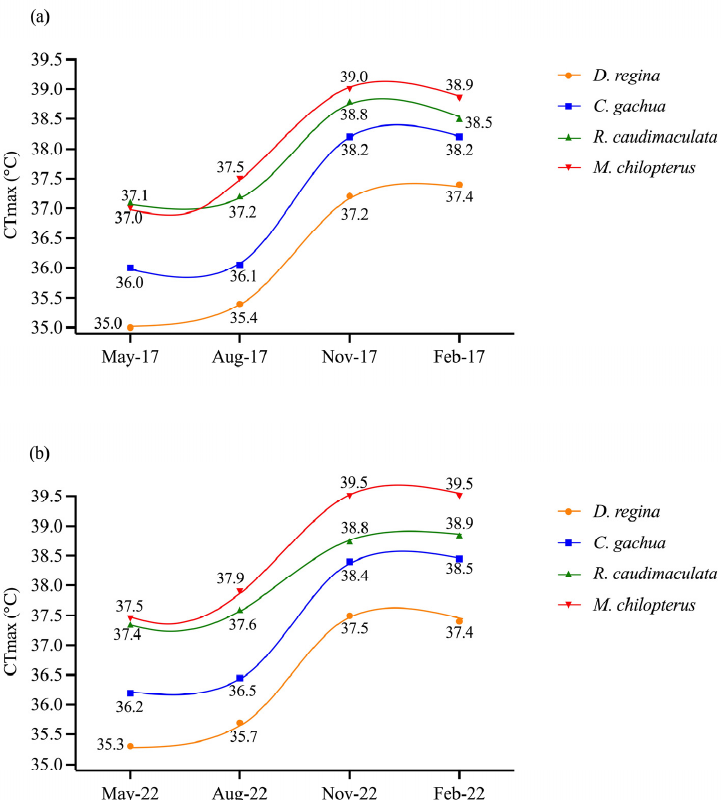
Figure 6. Seasonal changes of thermal tolerance or critical thermal maximum (CTmax) for four species acclimated to 25 °C and measured in mid-May (early wet season), mid-August (late wet season), mid-November (early dry season) and mid-February (late dry season) during 2017 ( a ) and 2020 ( b ). Values are median for 20 fish.